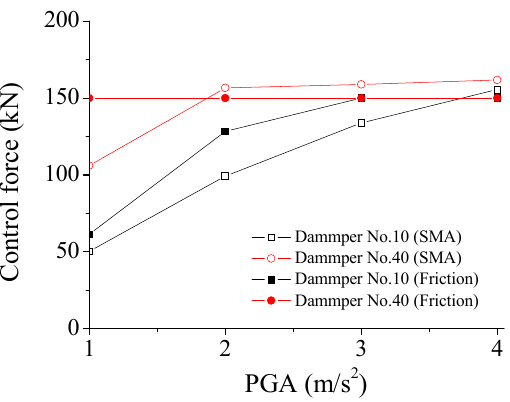
Figure 17. Variation of control force with seismic intensity. Table 5. Comparison of VRFs with different control approaches under different earthquake